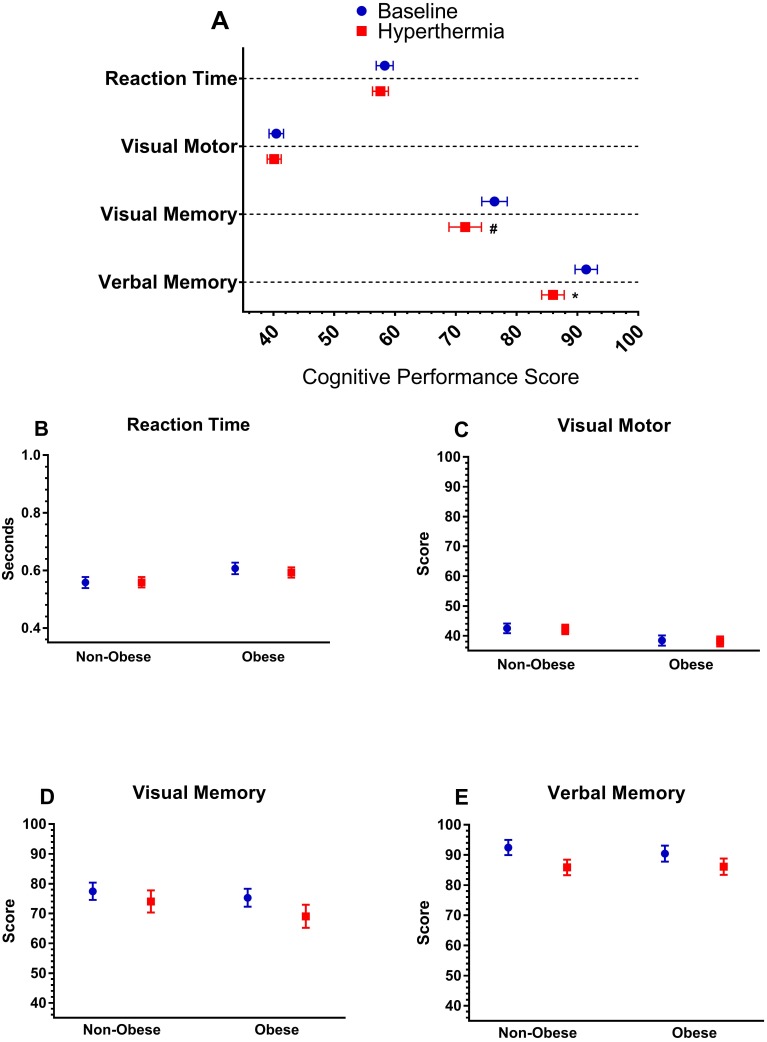
Cognitive performance.(A) Cognitive performance variables (y-axis) from the ImPACT at baseline and during hyperthermia. Below are (B) reaction time (C) visual motor performance, (D) visual memory, and (E) verbal memory from the ImPACT for each group (obese and non-obese) at baseline and during hyperthermia. *Indicates significant difference from baseline (p < 0.05), #Indicates a trend for a difference between baseline (p < 0.10). Symbols in (A) are vertically offset for clarity.